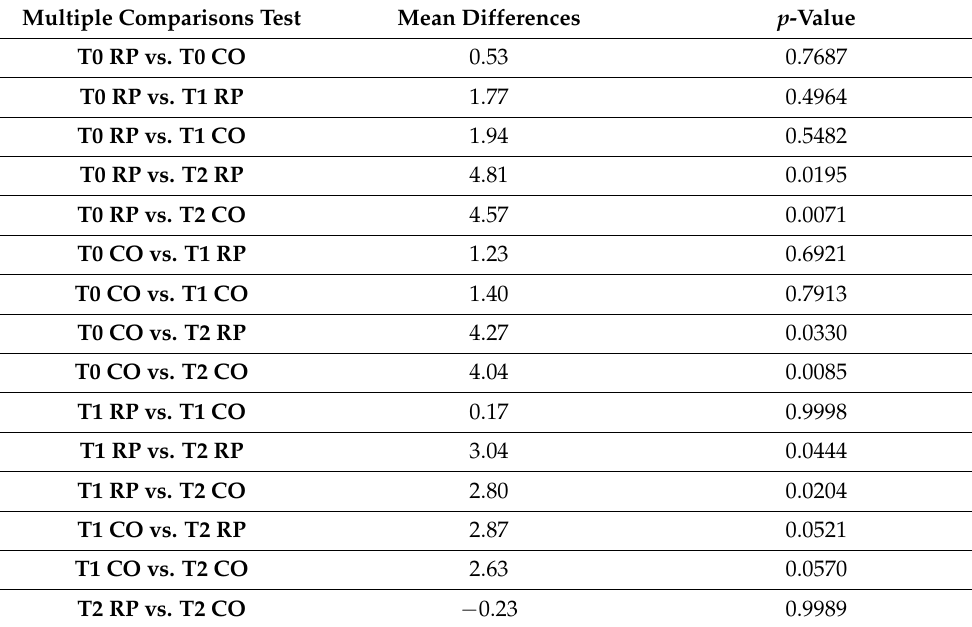
Table 4. Tukey’s multiple comparisons of the repeated measures ANOVA test on